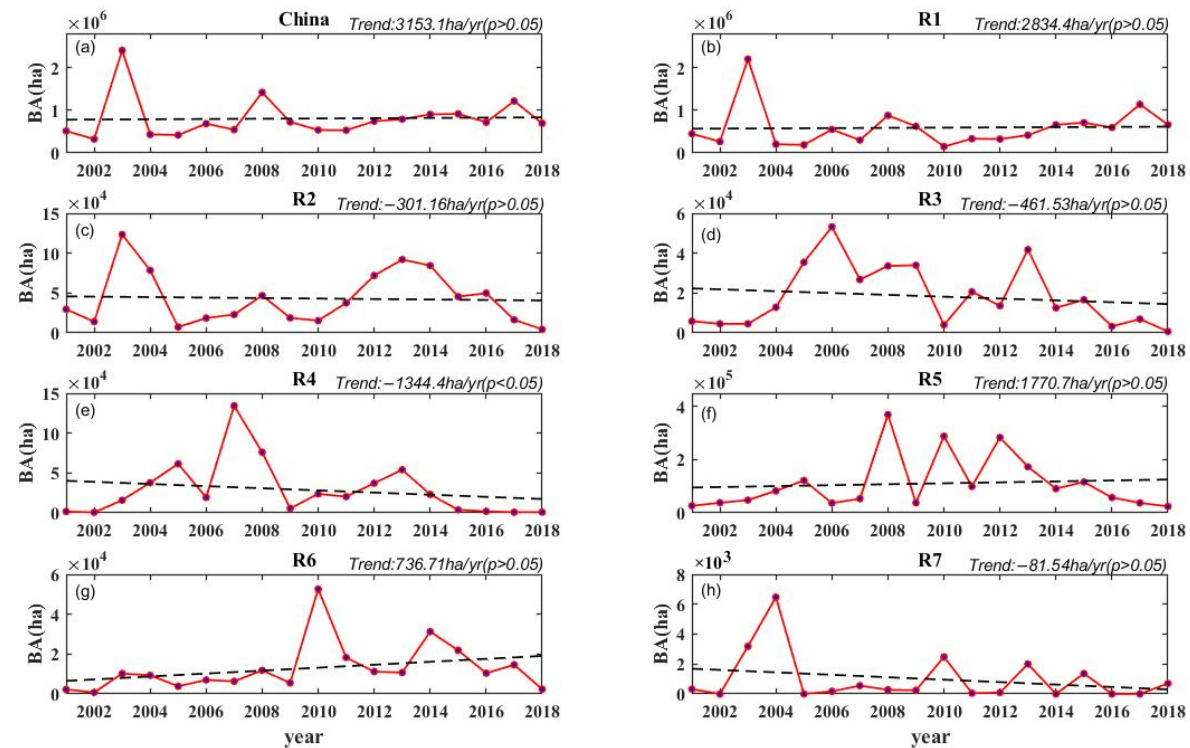
Figure 5. The trends of the BA in China and R1–R7 in spring.